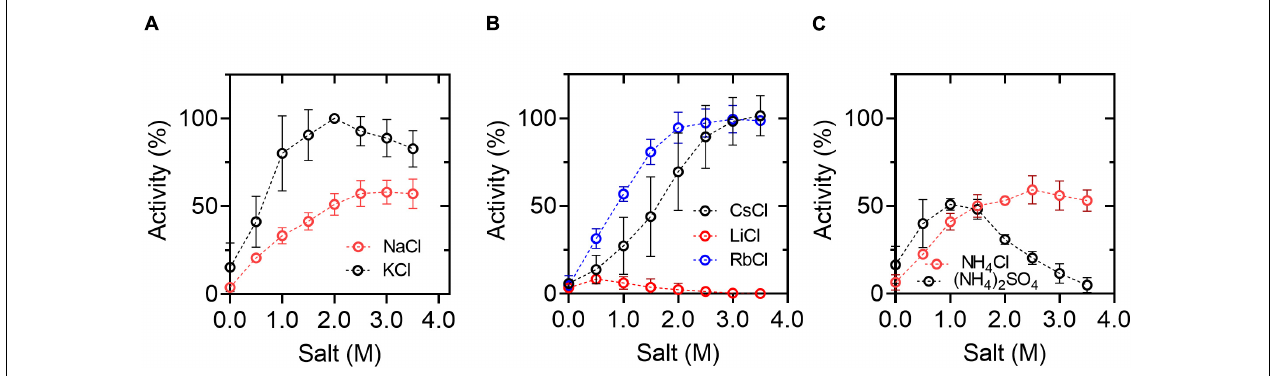
FIGURE 2 | Effect of chloride salts on Hv G6PDH activity. (A) Activity curves in the presence of KCl or NaCl. (B) Activity curves in the presence of CsCl, LiCl, or RbCl. (C) Activity curves in the presence of NH 4 Cl or (NH 4 ) 2 SO 4 . The activity was assayed at 25 ◦ C in the presence of 30 mM G6P and 3 mM NAD + . In all assays, 100 mM of residual KCl was present due to the Hv G6PDH storage buffer. The data was normalized, taking the activity that registered at 2.0 M KCl as 100%. The means and standard deviations of three replicates are shown.